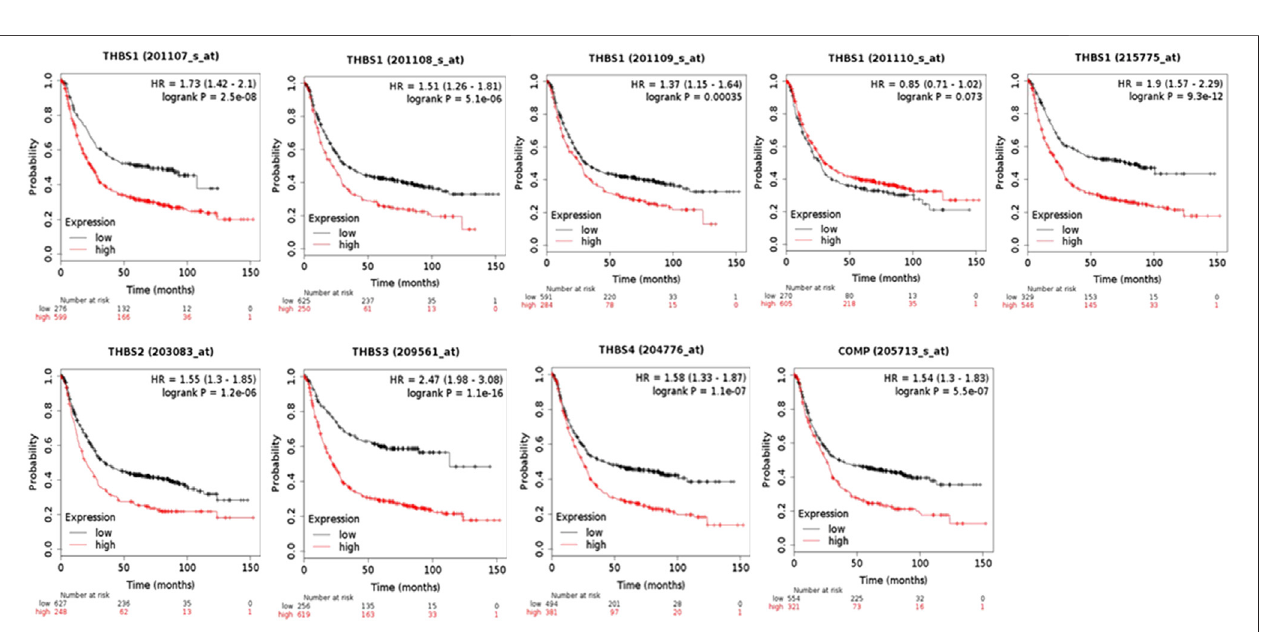
FIGURE 3 | The overall survival analysis of the patients with gastric cancer grouped by expression levels of THBSs (Kaplan – Meier plotter).